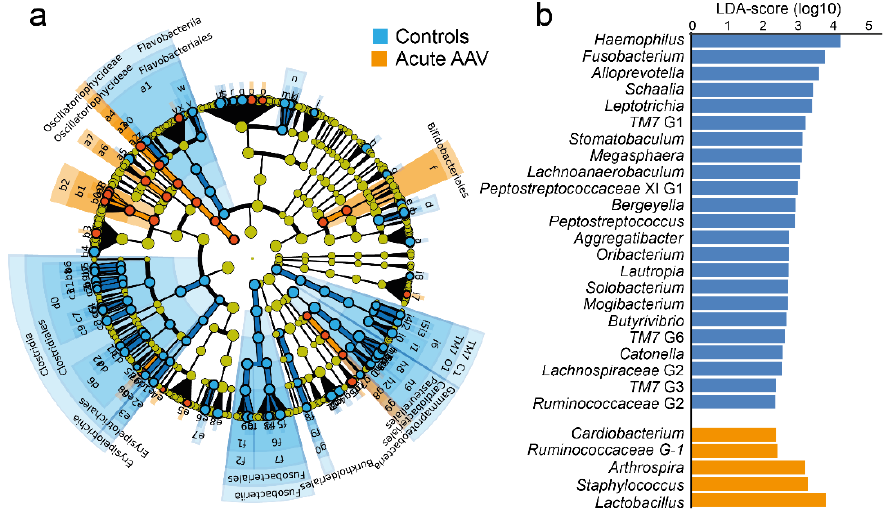
Figure 5. LEfSe analysis of saliva microbiota from controls and acute AAV patients. ( a ) Cladogram, based on phylum, class, order, family, genus, and species abundances in control and acute AAV samples. Indicated taxa differ between the two groups (LDA score > 2.0, p < 0.05). ( b ) Bar graphs showing LDA scores for genus-level differences between the control and acute AAV groups. LDA scores are given on a log10 scale.